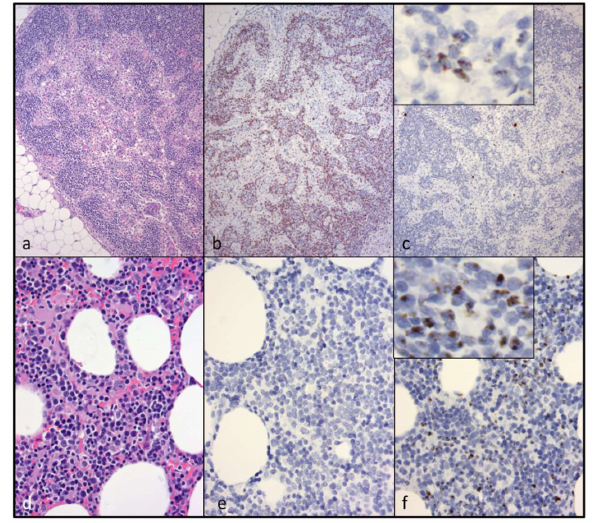
Figure 4. An atrophied mesenteric lymph node (LN) and bone marrow contain moderate amounts of viral nucleic acid, but are variably positive for CD3+ T cells. ( a ) The mesenteric LN has a poorly